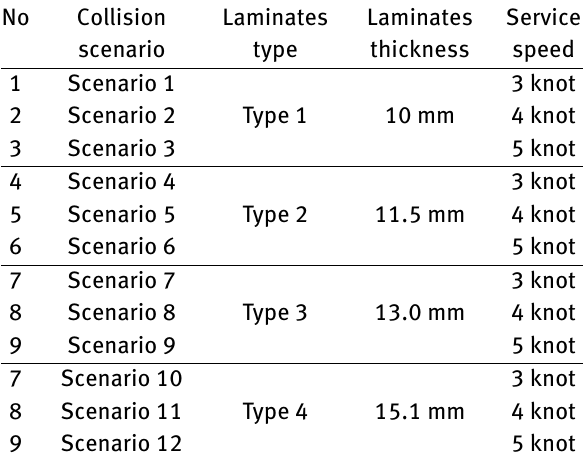
Table 6: Scenarios of ship and harbor quay collision simulation